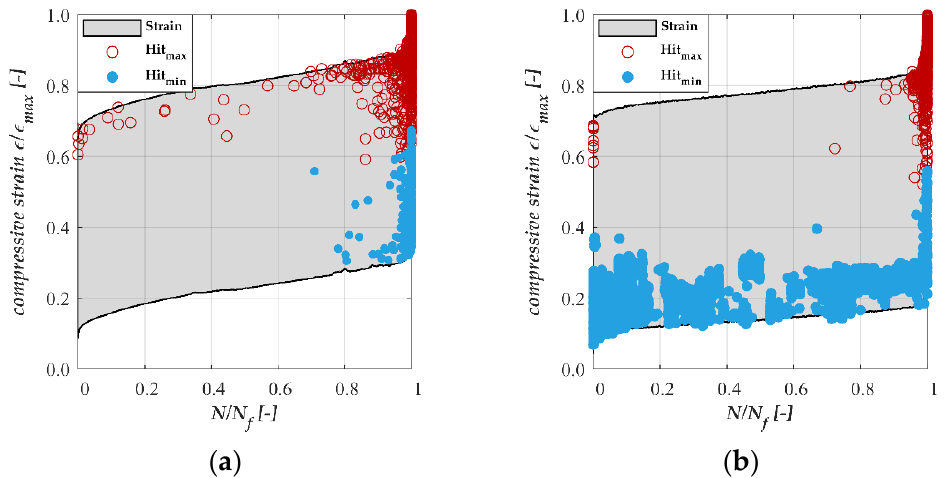
Figure 4. Representative acoustic emission signals during fatigue loading: ( a ) of storage condition C ; ( b ) of storage condition WS